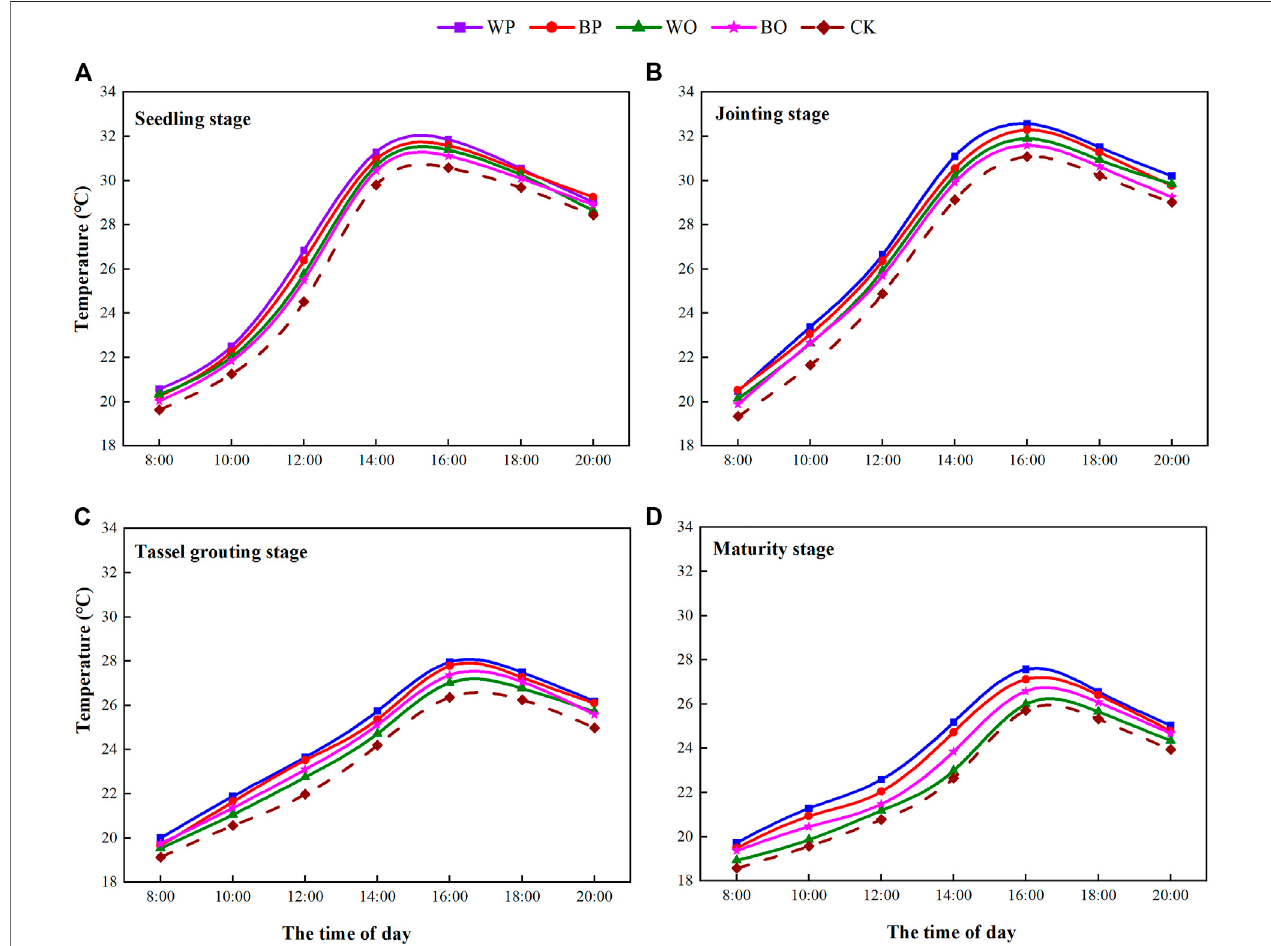
FIGURE2| Diurnalvariationsofsoiltemperature in0 – 15cmsoillayerunderdifferentmulching fi lmsofSeedlingstage (A) ,Jointingstage (B) ,Tasselgroutingstage (C) and Maturity stage (D) .